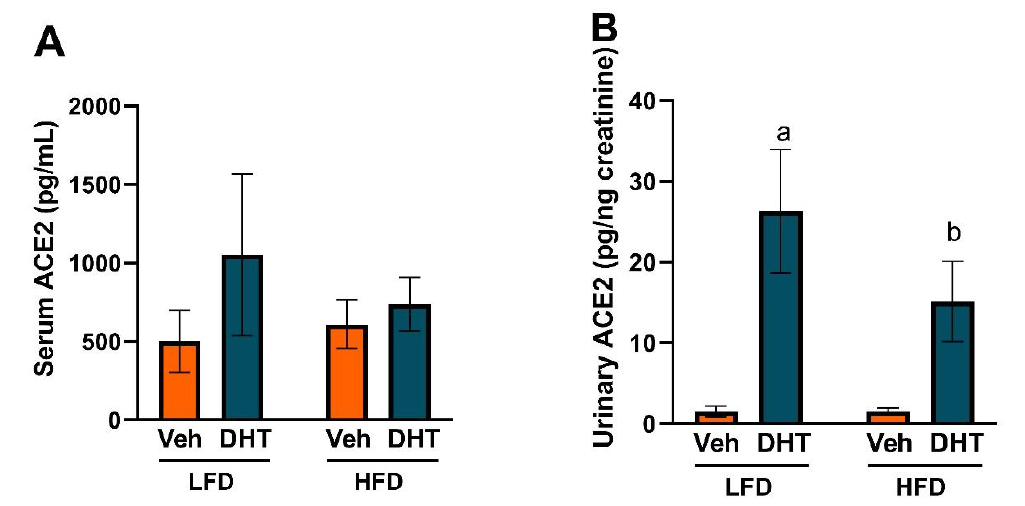
Figure 5. Effect of DHT and diet on serum and urinary ACE2. Animals were treated with dihydrotestosterone (DHT) or vehicle (Veh) and maintained in low (LFD) or high (HFD) fat diet for 90 days. Serum ( A , N = 4–7/group) and urinary ( B , N = 4–6/group) ACE2 were quantified by ELISA. Urinary ACE2 was corrected by urinary creatinine. Data are expressed as mean ± SEM. Data were analyzed by two-way ANOVA followed by Fisher’s LSD test. a p < 0.05 vs. LFD-Veh; b p < 0.05 vs. HFD-Veh.